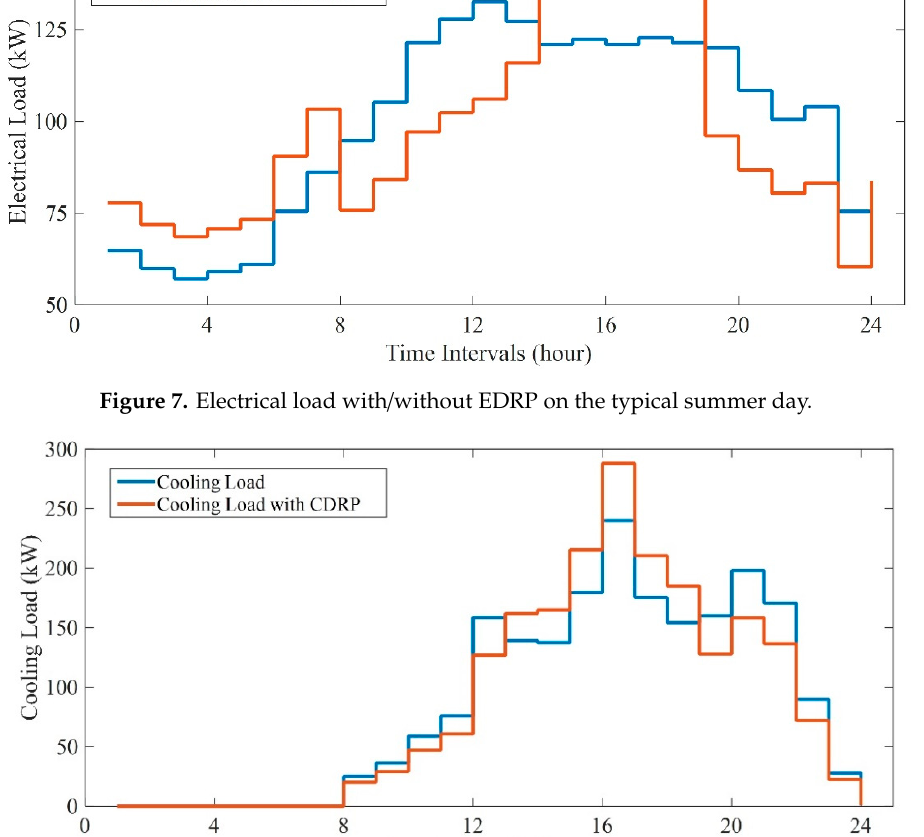
Figure 8. Cooling load with / without cooling demand response program (CDRP) on the typical summer day.